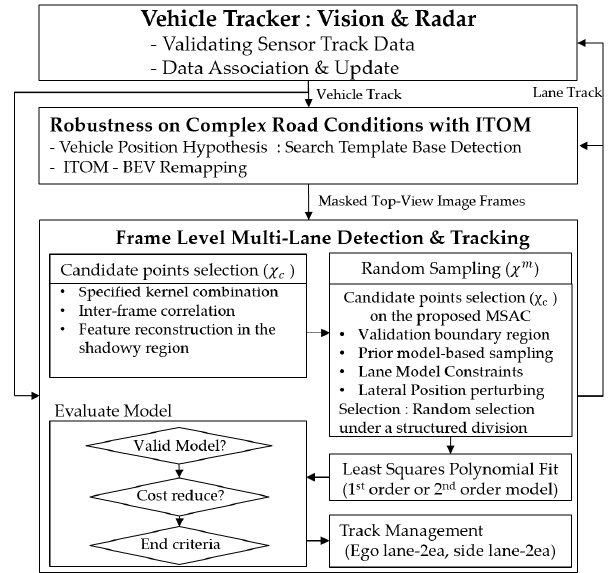
Figure 4. The robust multi-lane detection and tracking algorithm.